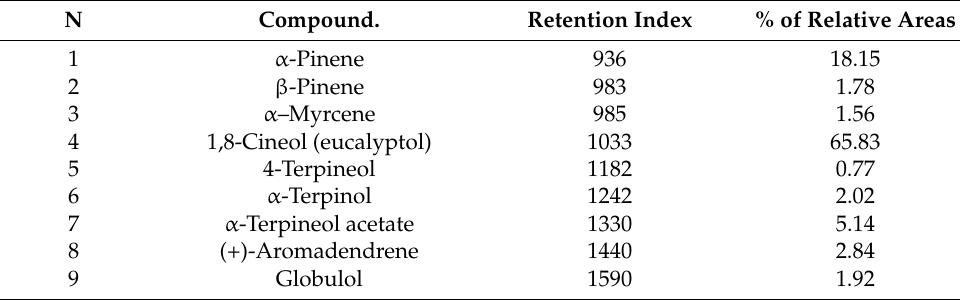
Table 2. Components in the essential oil of E. globulus .